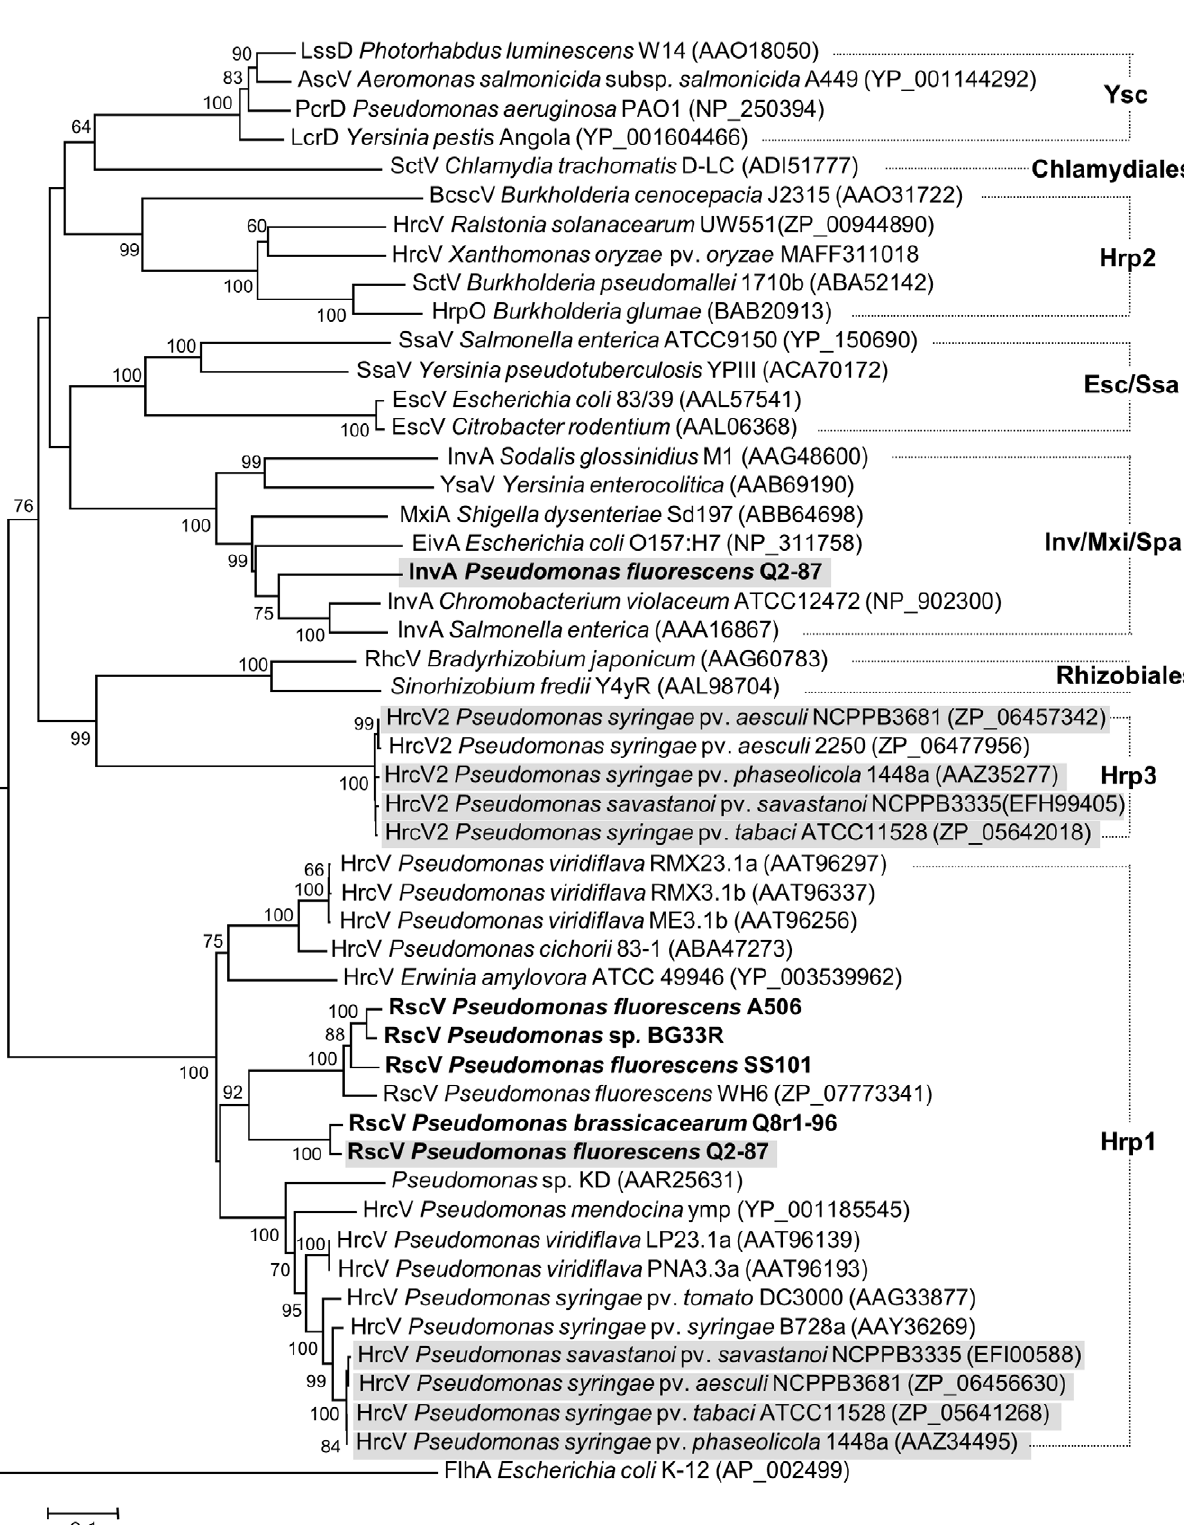
Figure 8. Neighbor-joining phylogeny inferred from aligned amino acid sequences of Hrc(Rsc)V proteins. Pseudomonas strains with genomes sequenced in this study are highlighted in boldface, whereas strains carrying two different type III secretion systems are shaded in gray. GenBank accession numbers are shown in brackets. Families of T3SSs are labeled according to Troisfontaines and Cornelis [112]. Flagellar export pore protein FlhA from E. coli was used as an outgroup. Indels were ignored during analyses. Evolutionary distances for Hrc(Rsc)V proteins were estimated using the Jones-Taylor-Thornton (JTT) model [177] of amino acid substitution. Bootstrap values equal to or greater than 60% are shown, and the scale bar represents the number of substitutions per site. Branch lengths are proportional to the amount of evolutionary change. doi:10.1371/journal.pgen.1002784.g008 PLoS Genetics |